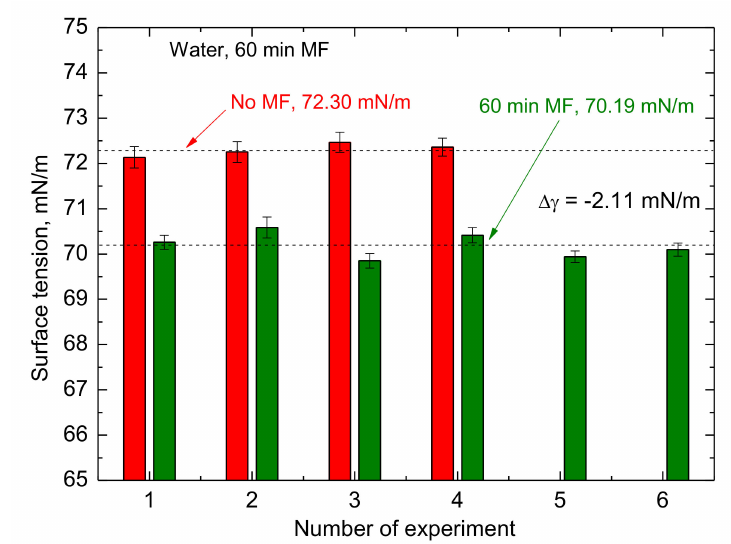
Figure 10. The surface tension measured for four untreated and six 1 h MF-treated samples at the room temperature 24.2 ± 0.2 ◦ C.